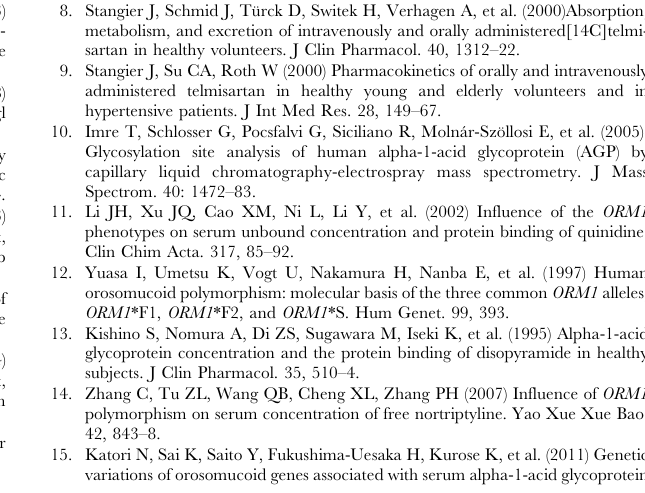
Table S1 The clinical characteristics data and baseline